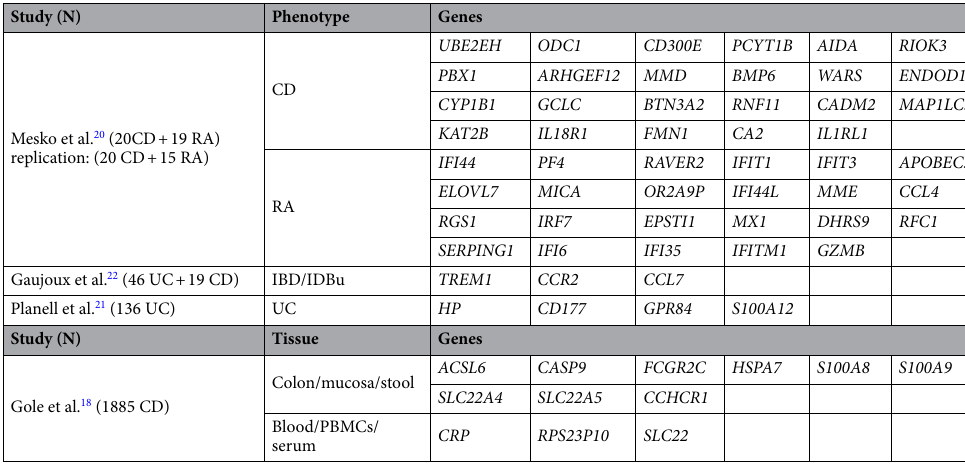
Table 1. Previously identified anti-TNF response genes in PBMC and integrated genomic markers. CD Crohn’s disease, RA rheumatoid arthritis, IBD inflammatory bowel disease, IBDu inflammatory bowel disease unclassified, UC ulcerative